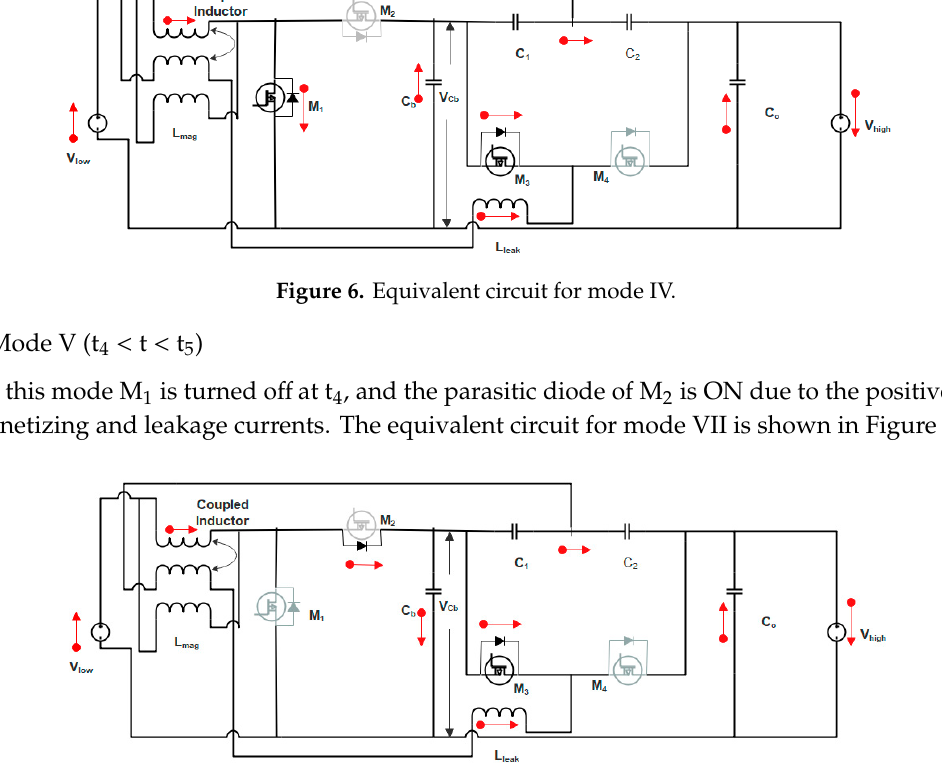
Figure 7. Equivalent circuit for mode V.